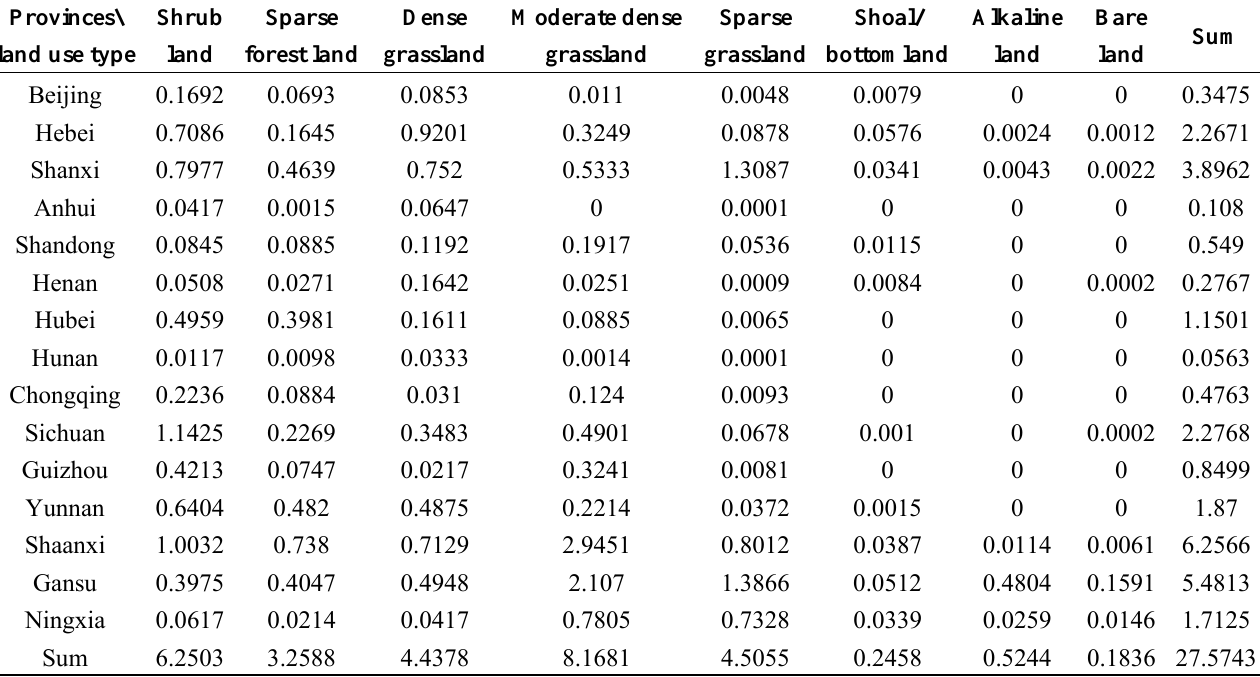
Table 4. Evaluation results of marginal land of each province fairly suitable for planting Pistacia chinensis (million